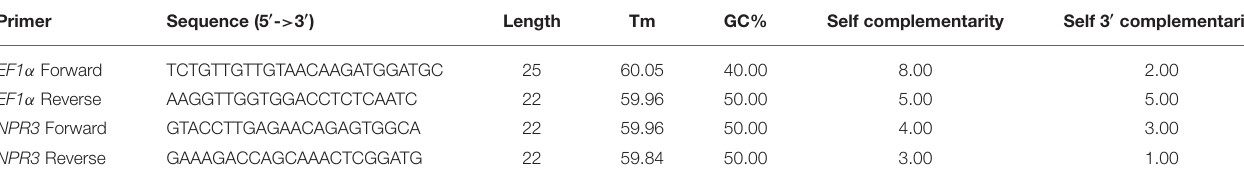
TABLE 1 | Primer sequences used for RT_PCR analysis of a defense-related gene. Primer Sequence (5 ′ - > 3 ′